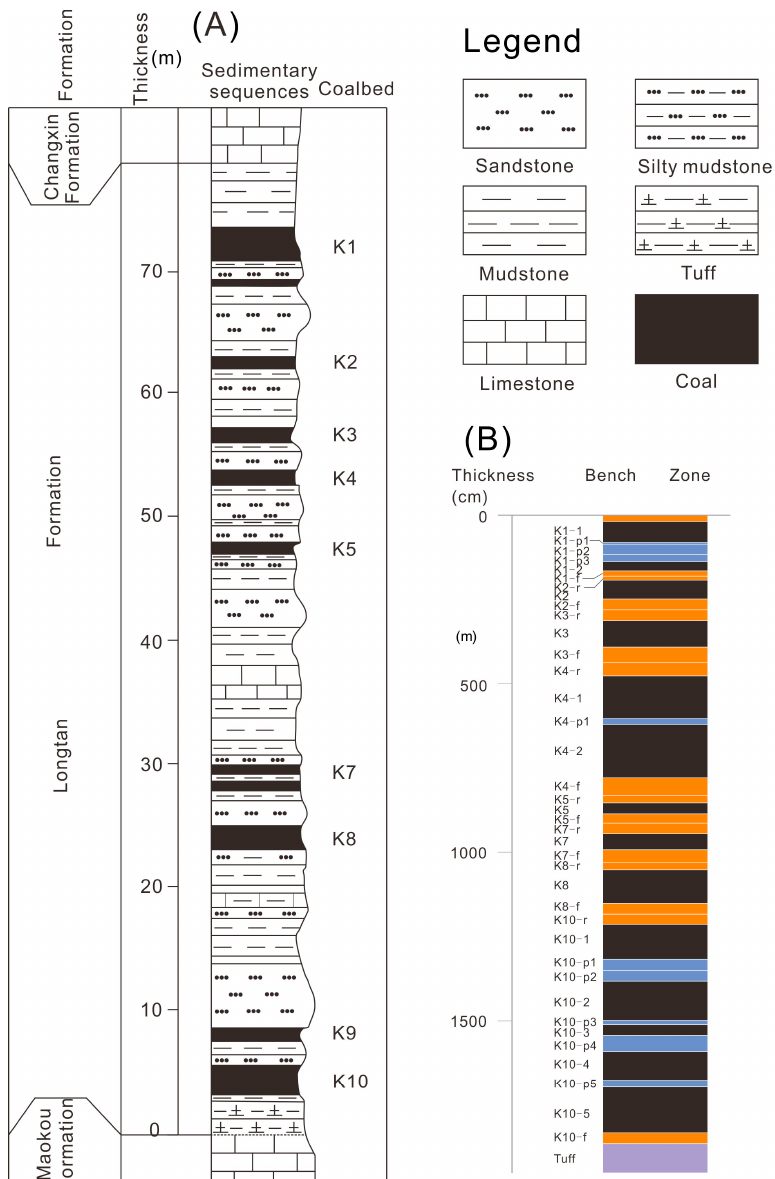
Figure 2. Sedimentary sequences of the Zhongliangshan Coalfield ( A ) and the collected samples of the ZK4-1 drill core in present study ( B ). Partings in blue, host rocks (roof and floor strata) in orange, tuff in purple, and coal benches in black. The suffixes r, f, and p stand for roof, floor, and partings, respectively.